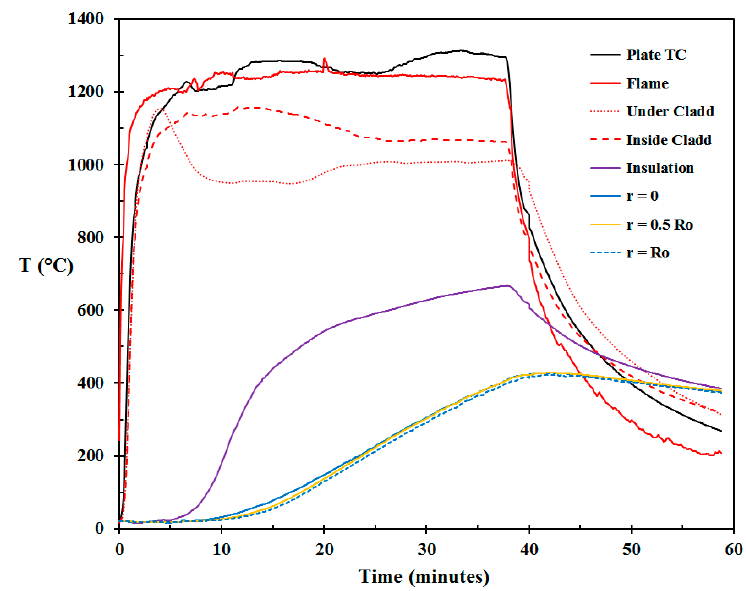
Figure 11. Thermal insulation ( a ) and cladding ( b ) after Test 1.